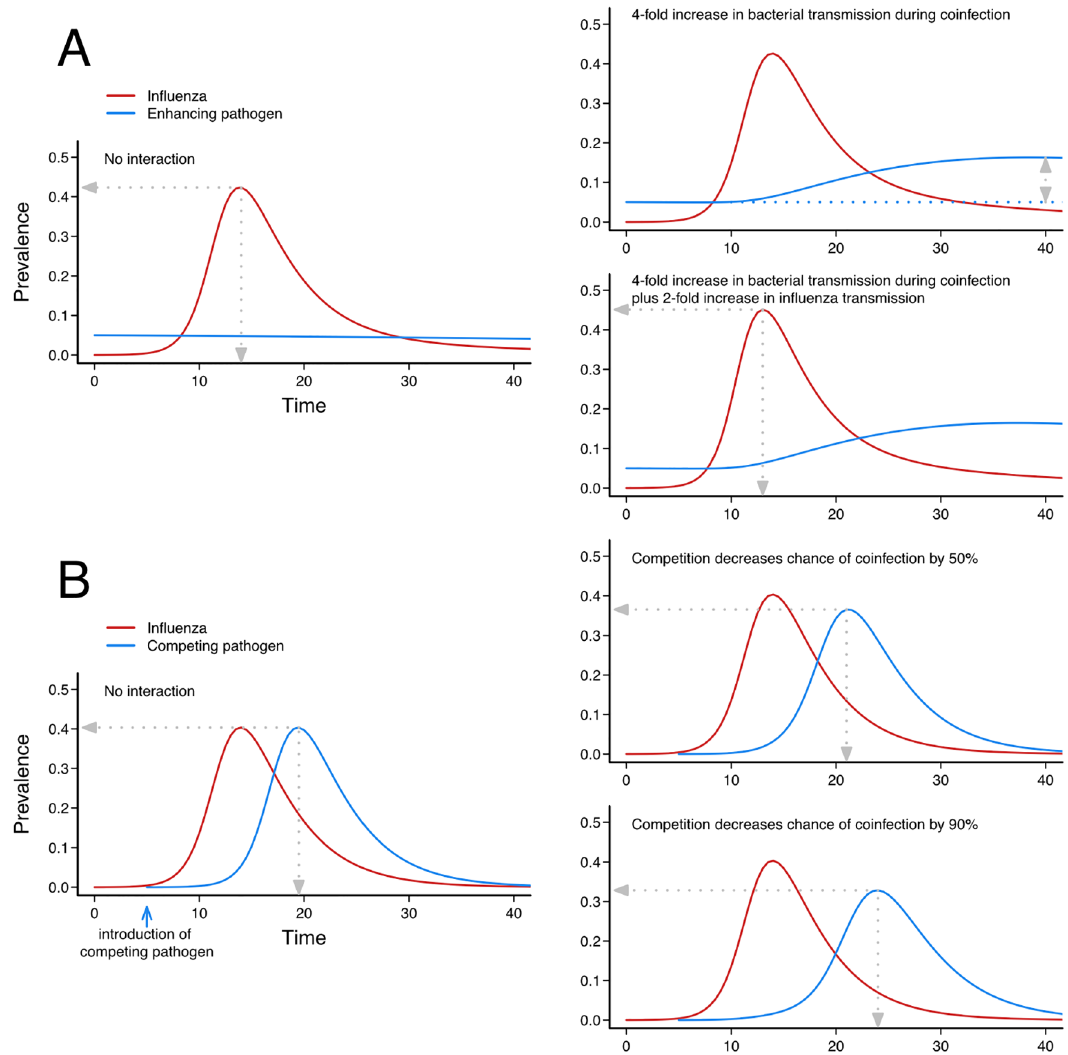
Fig 4. Example model outputs showing effect of synergistic and competitive interaction. Box 3 gives details on the model that produces these epidemic trajectories. (A) In the baseline enhancing scenario, an endemic bacterial pathogen (blue) occurs at 5% prevalence. An influenza epidemic occurs with no interaction, and the bacterial prevalence does not change. If the presence of influenza coinfection increases bacterial transmissibility by 4-fold ( σ = 4), then there is a transient rise in bacterial prevalence. If 1 there is also an increase in influenza transmissibility during coinfection ( σ 1 = 4 and σ 2 = 2), then there is also a higher and earlier influenza peak as a result of coinfection. (B) In the baseline competition scenario, the second epidemic pathogen is introduced later than influenza. The two pathogens have the same transmission characteristics (same γ , same β ). If there is only a 50% chance of infection with pathogen 2 when individuals are infected with pathogen 1 ( δ = 0.5), then the epidemic trajectory of pathogen 2 is 1 lower and later. If competition is even stronger ( δ 1 = 0.1) so there is a 90% reduction in chance of coinfection, the profile of pathogen 2 is even further separated from pathogen 1. Computer code generating these trajectories is given in S1